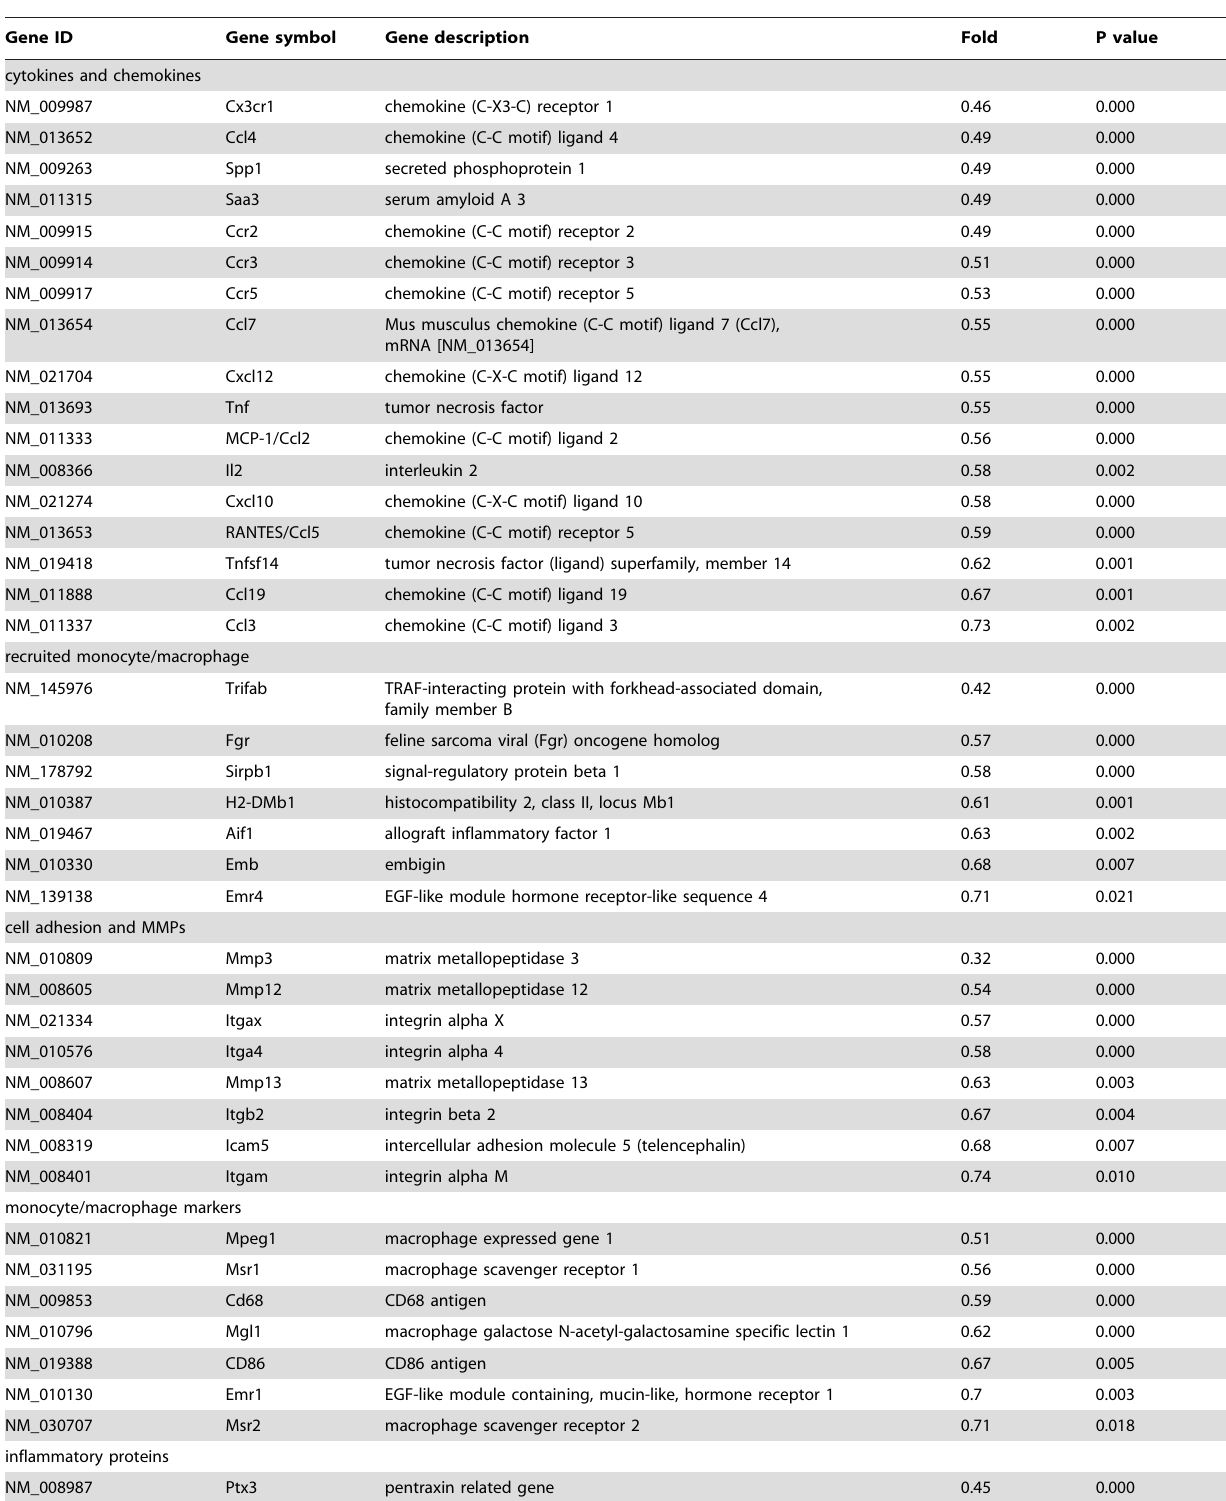
Table 1. Effect of vitamin B6 supplementation on adipose tissue gene expression in mice fed a high fat diet.